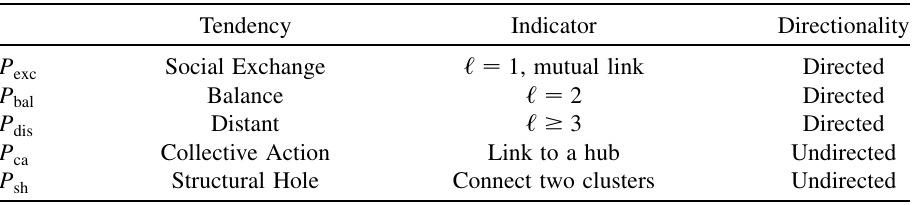
TABLE I. List of tendencies, indicators, and the type of directionality in the network used to detect the tendency. ‘ is the distance between two nodes as measured by the shortest path in the directed